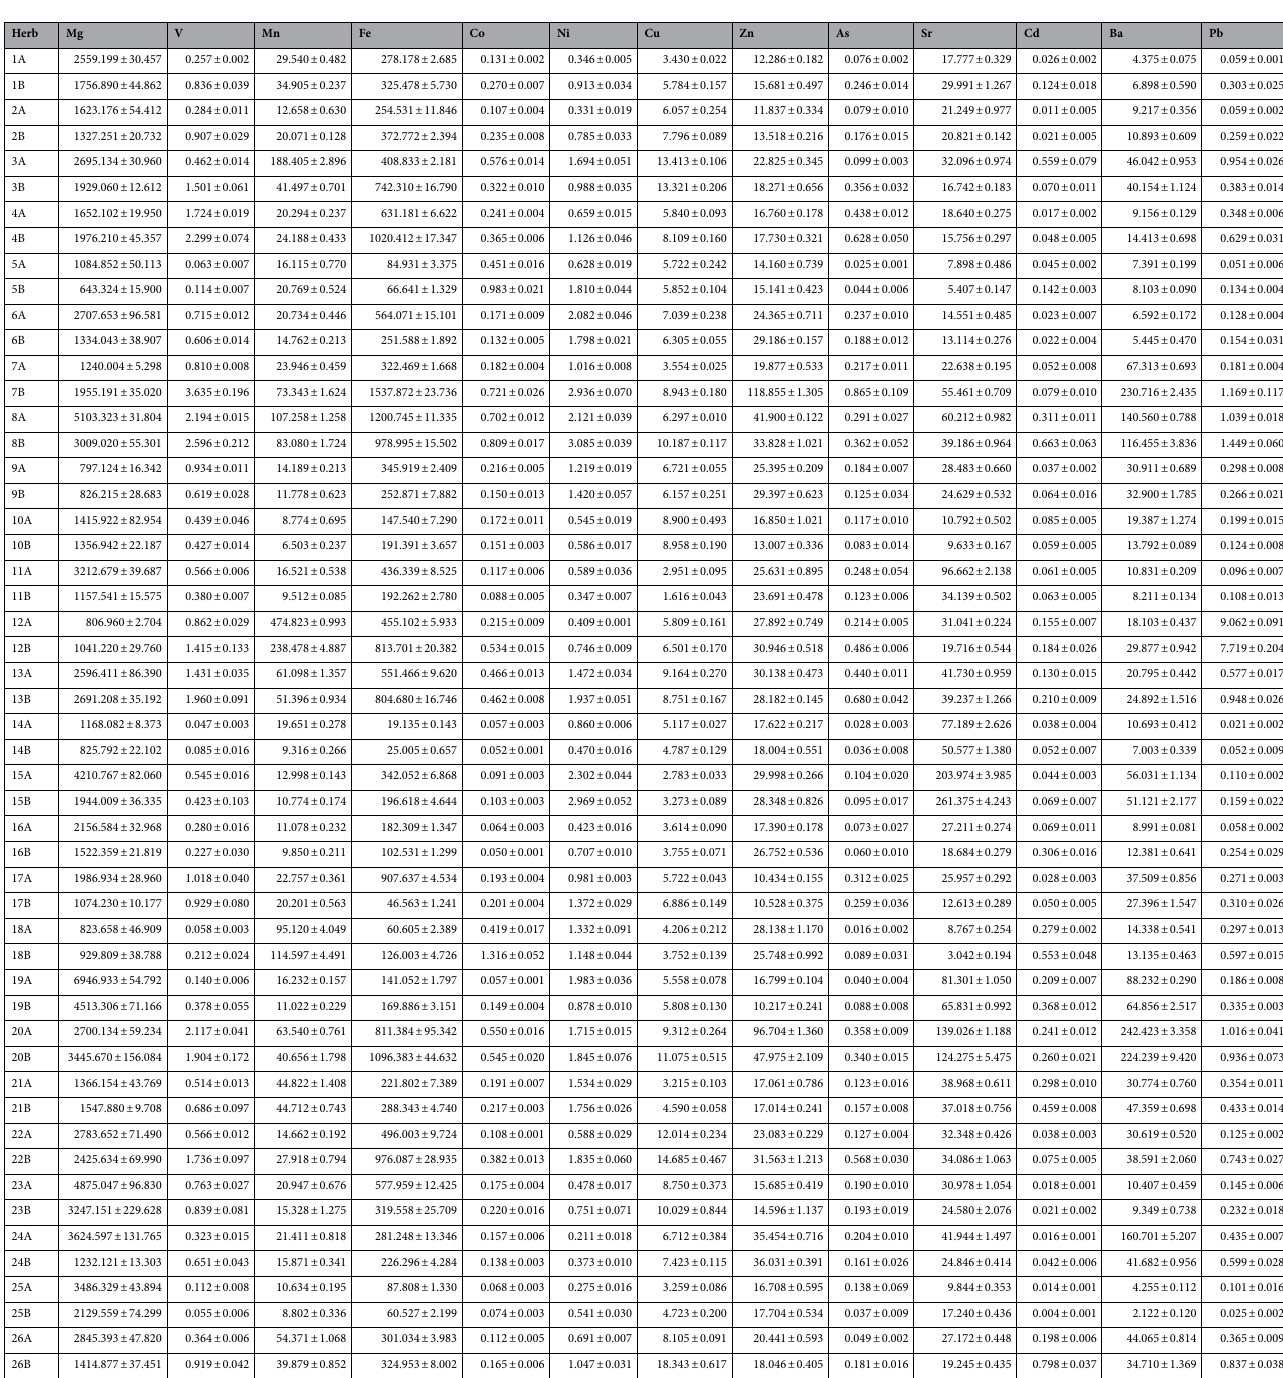
Table 4. The measurement results of 13 elements in 26 herb roots each analyzed in two batches purchased 1 year apart ( n = 52 ). Each measurement was performed in triplicate and the result is presented as the average ± SD. All values are in mg kg −1 . Batches of herb roots from 2020 and 2021 are marked as A and B,